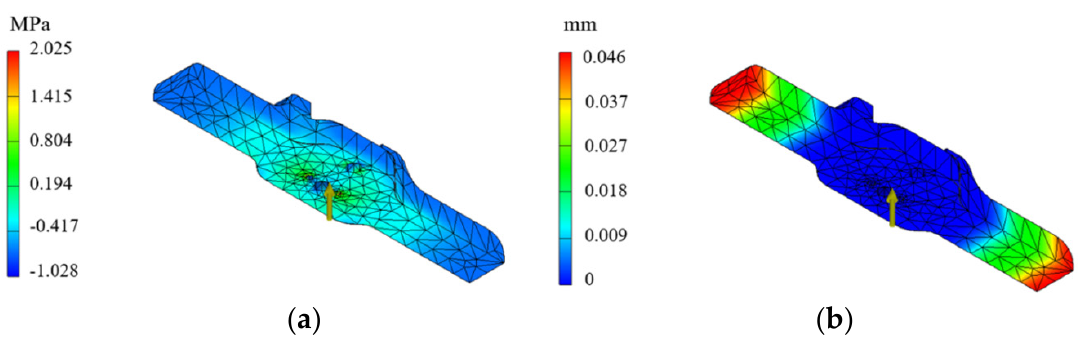
Figure 3. Analysis models of the DAM using a finite element analysis (FEA). ( a ) Stress analytical result. ( b ) Displacement analytical result.